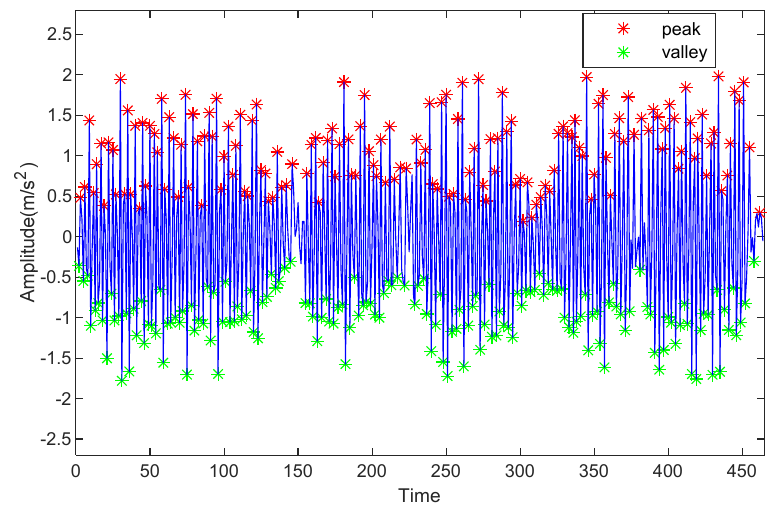
Figure 10. Peak and valley detection of acceleration.